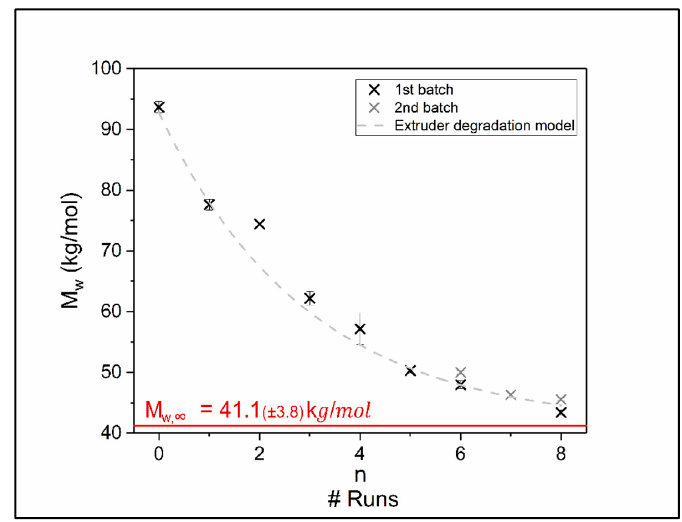
Figure 3. Decrease of M w as a function of recycling runs for fixed temperature (T = 205 ◦ C) and fixed extruder rotational speed (33 rpm). The dashed line shows the best fit of Equation (1).